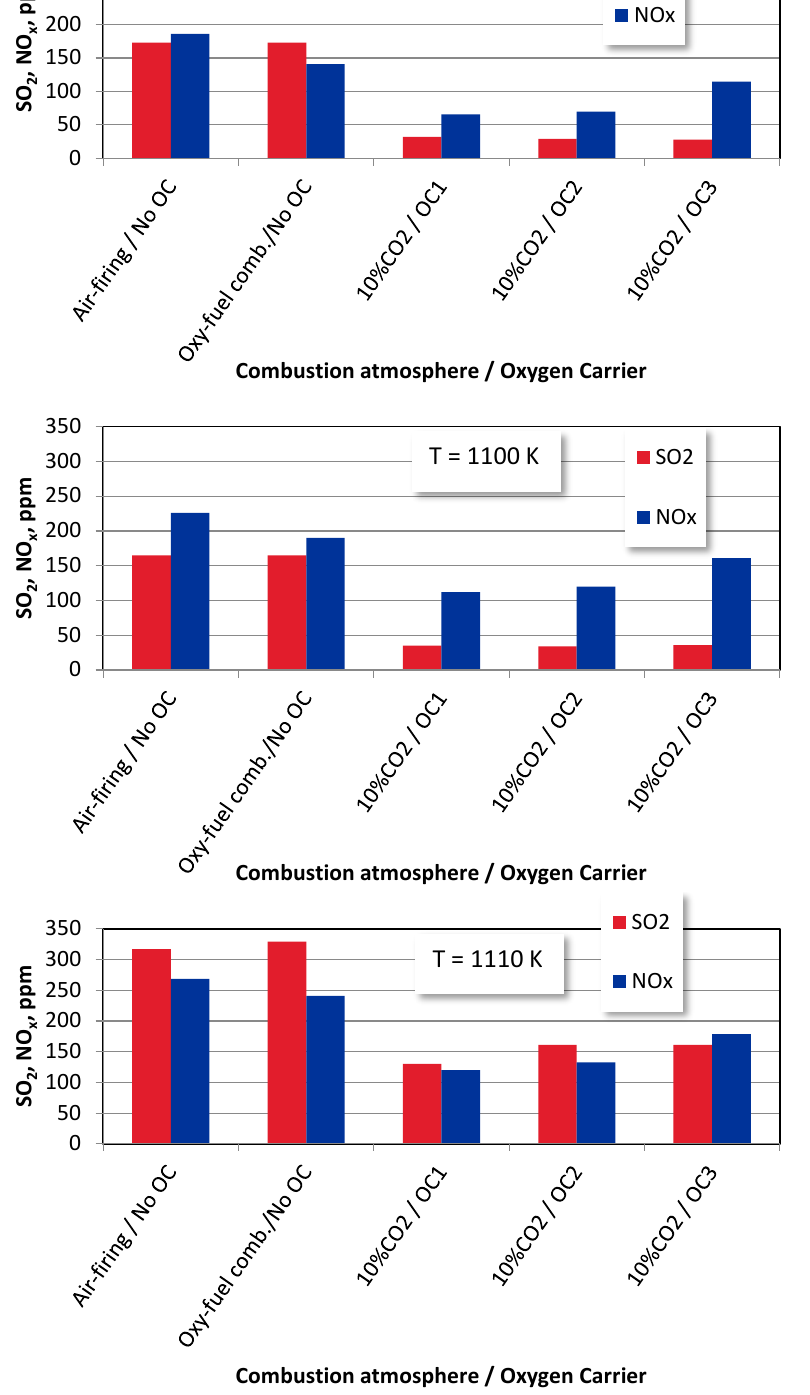
Figure 10. The average fuel reactor temperature effect on SO 2 and NO x emissions from bituminous coal combustion under different combustion modes (OE = 10%).